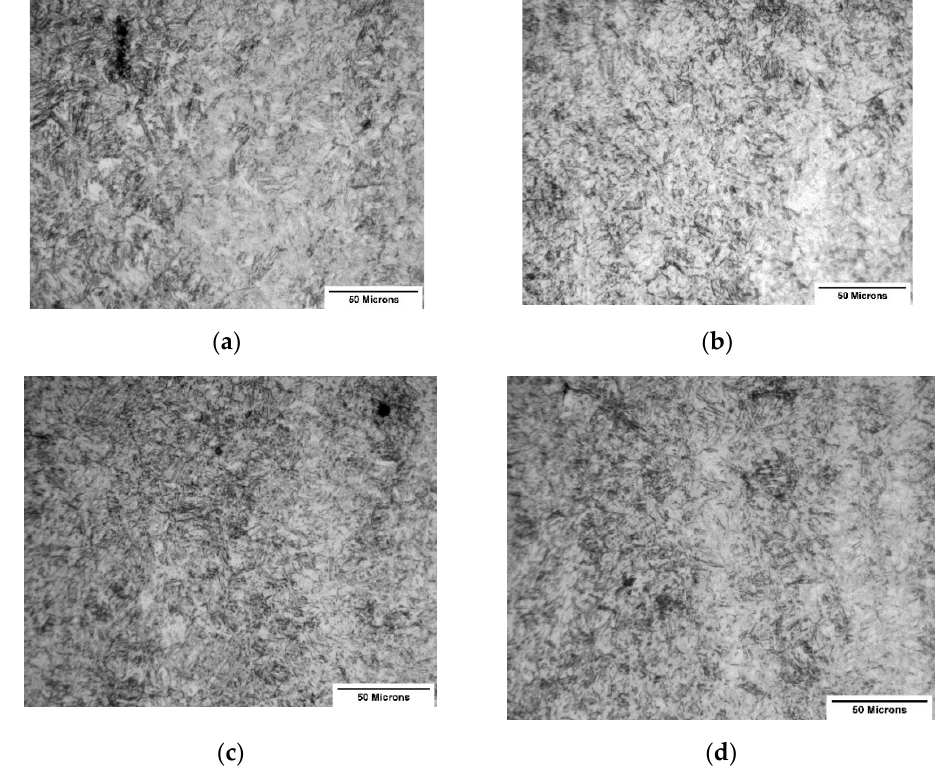
Figure 8. Obtained microstructure after quenching treatment of AISI-4340 steel at 500×: ( a ) V-OQ; ( b ) H-OQ; ( c ) V-WQ; and ( d ) H-WQ.